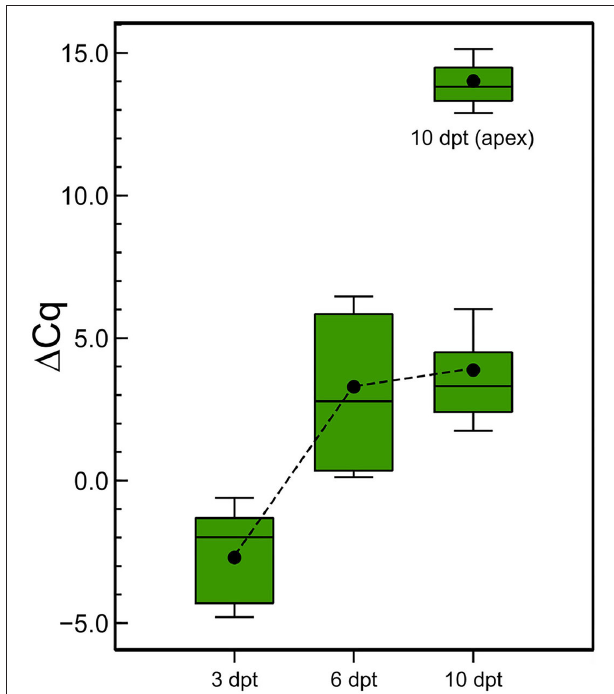
FIGURE 8 | Stability of the dsRNA in the plants after topical application. Detection by RT-qPCR of cp-(ds)RNA at 3, 6, and 10 days post CP-dsRNA application using spraying. Another sampling was done at the apex at 10